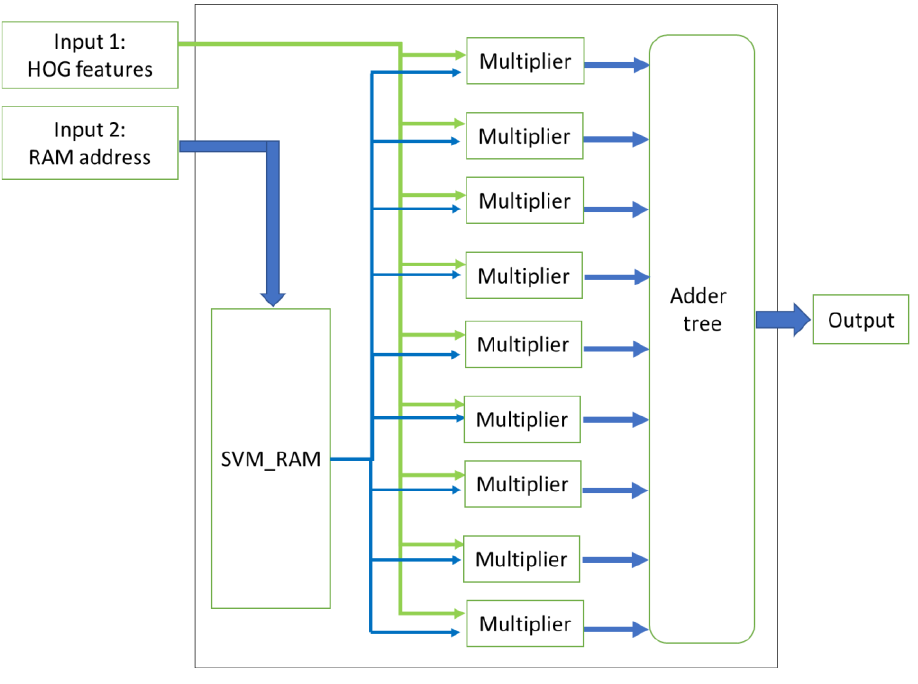
Figure 15. SVM block internal logic.